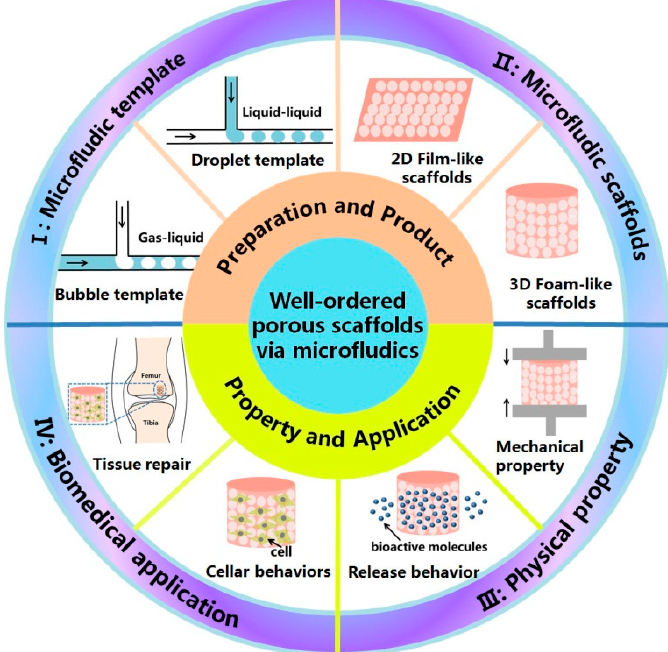
Figure 1. Schematic illustration of preparation and property of well-ordered porous scaffolds via microfluidic technology. Microfluidic template used for preparing the scaffolds, including bubble template and droplet template; The obtained microfluidic scaffolds, including 2D film-like scaffolds and 3D foam-like scaffolds; Physical property of the scaffolds, for example, mechanical property and release behavior of bioactive molecules; Biomedical application of the scaffolds, for example, in the field of tissue repair and cellar behaviors study.